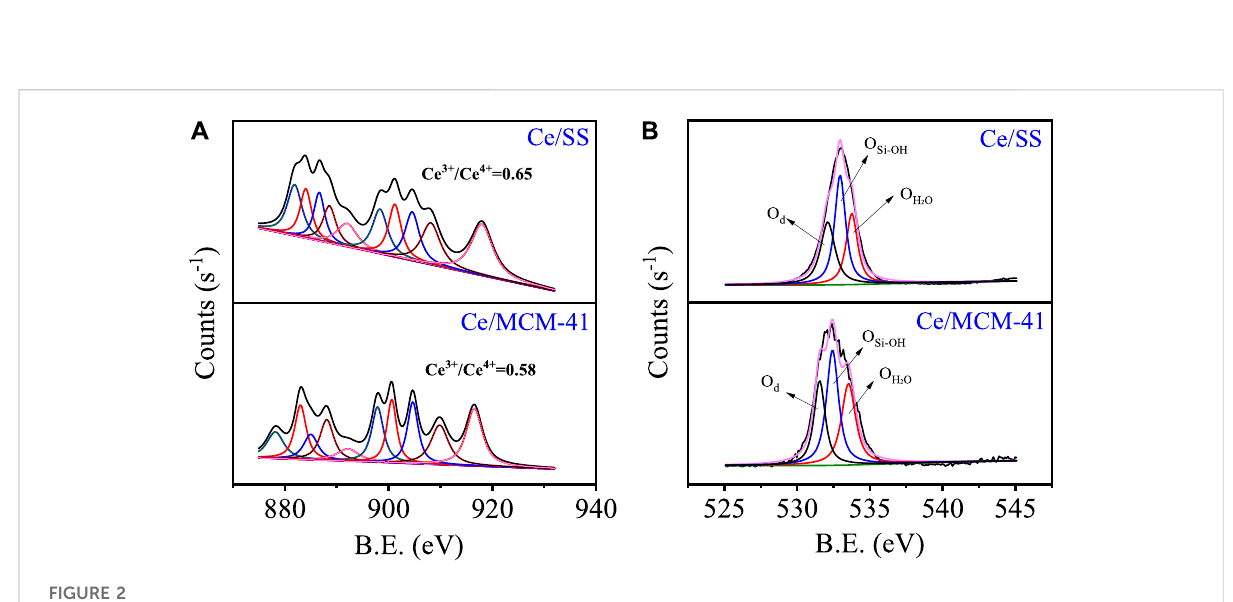
Frontiers in Environmental